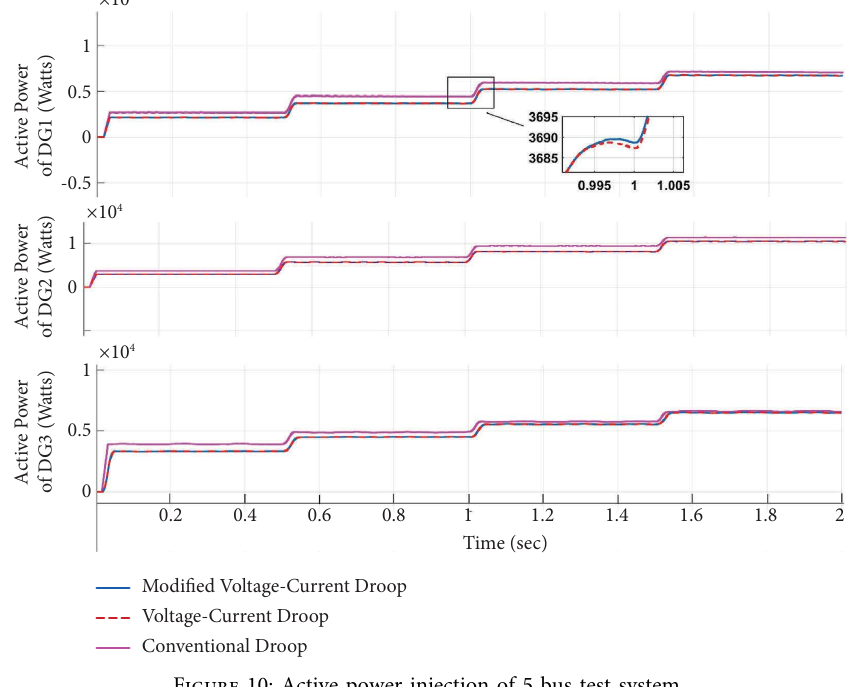
Figure 10: Active power injection of 5 bus test system.